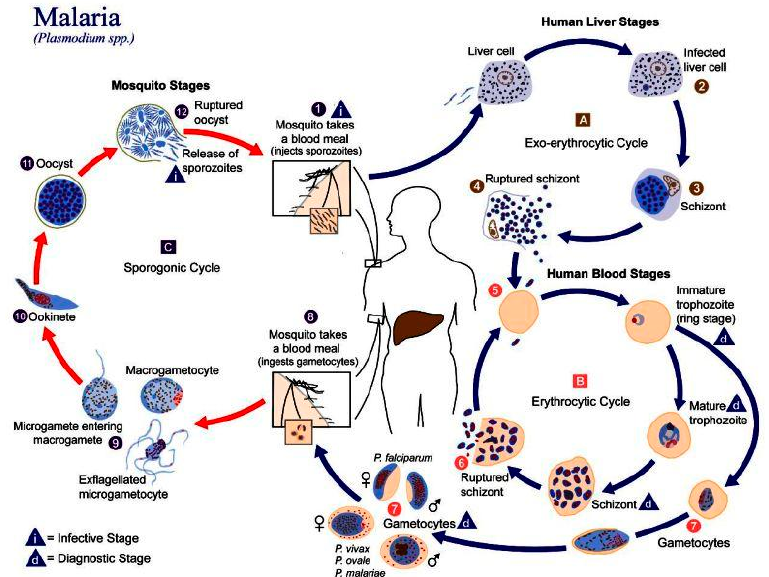
Figure 1. The life-cycle of Plasmodium spp . Reprinted, with permission, from the Centers for Disease Control and Prevention website, https://www.cdc.gov/malaria/about/biology/, accessed on October 2021. Use of this material, does not imply endorsement or recommendation by CDC, ATSDR, HHS or the United States Government of this research. Copyright, 2020, Centers for Disease Control and Prevention.